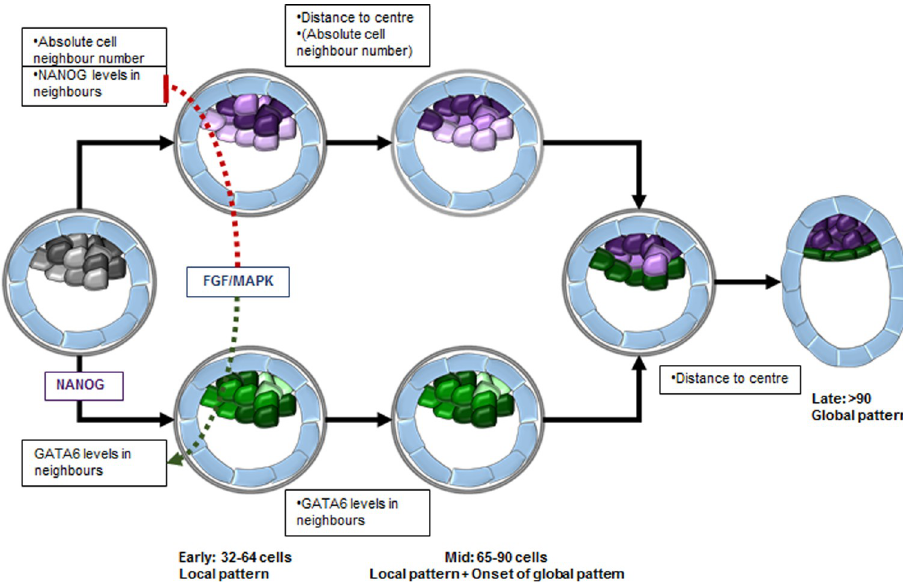
Fig 9. Model for transition from local to global patterns during cell fate decision in the ICM from early to late blastocysts. In early blastocysts, the majority of the ICM cells co-express NANOG and GATA6 but at different levels following a three-dimensional local pattern. NANOG levels in a cell correlate with the absolute cell neighbour number: cells with nine neighbours express the highest NANOG levels. GATA6 levels in a cell correlate with the average level expressed in its neighbours, resulting in clusters of cells with similar levels. FGF/MAPK signalling inhibits NANOG expression level clusters, which in turn, likely via NANOG inhibition on GATA6, promote GATA6 clusters. In mid blastocysts, the local patterns are comparable to those in early blastocysts and a global pattern starts to arise in NANOG expressing cells. In late blastocysts, the cells are segregated into two distinct cell groups and show a clear global pattern: NANOG expressing cells are located closest to the ICM centroid, while GATA6 expressing cells are away from the centroid. Hence, expression patterns occur already in early blastocysts, evolve in mid blastocysts and resolve in late blastocysts before the embryo implants. Grey represents NANOG-GATA6 co-expressing cells, purple represents NANOG expression in cells, and green represents GATA6 expression in cells.